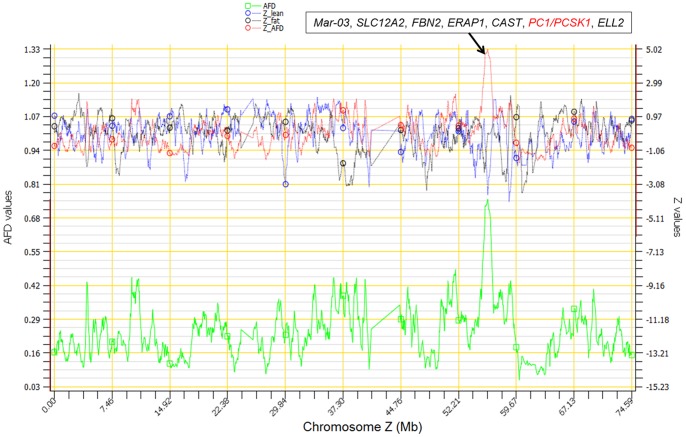
Long-range AFD and heterozygosity of chromosome Z.